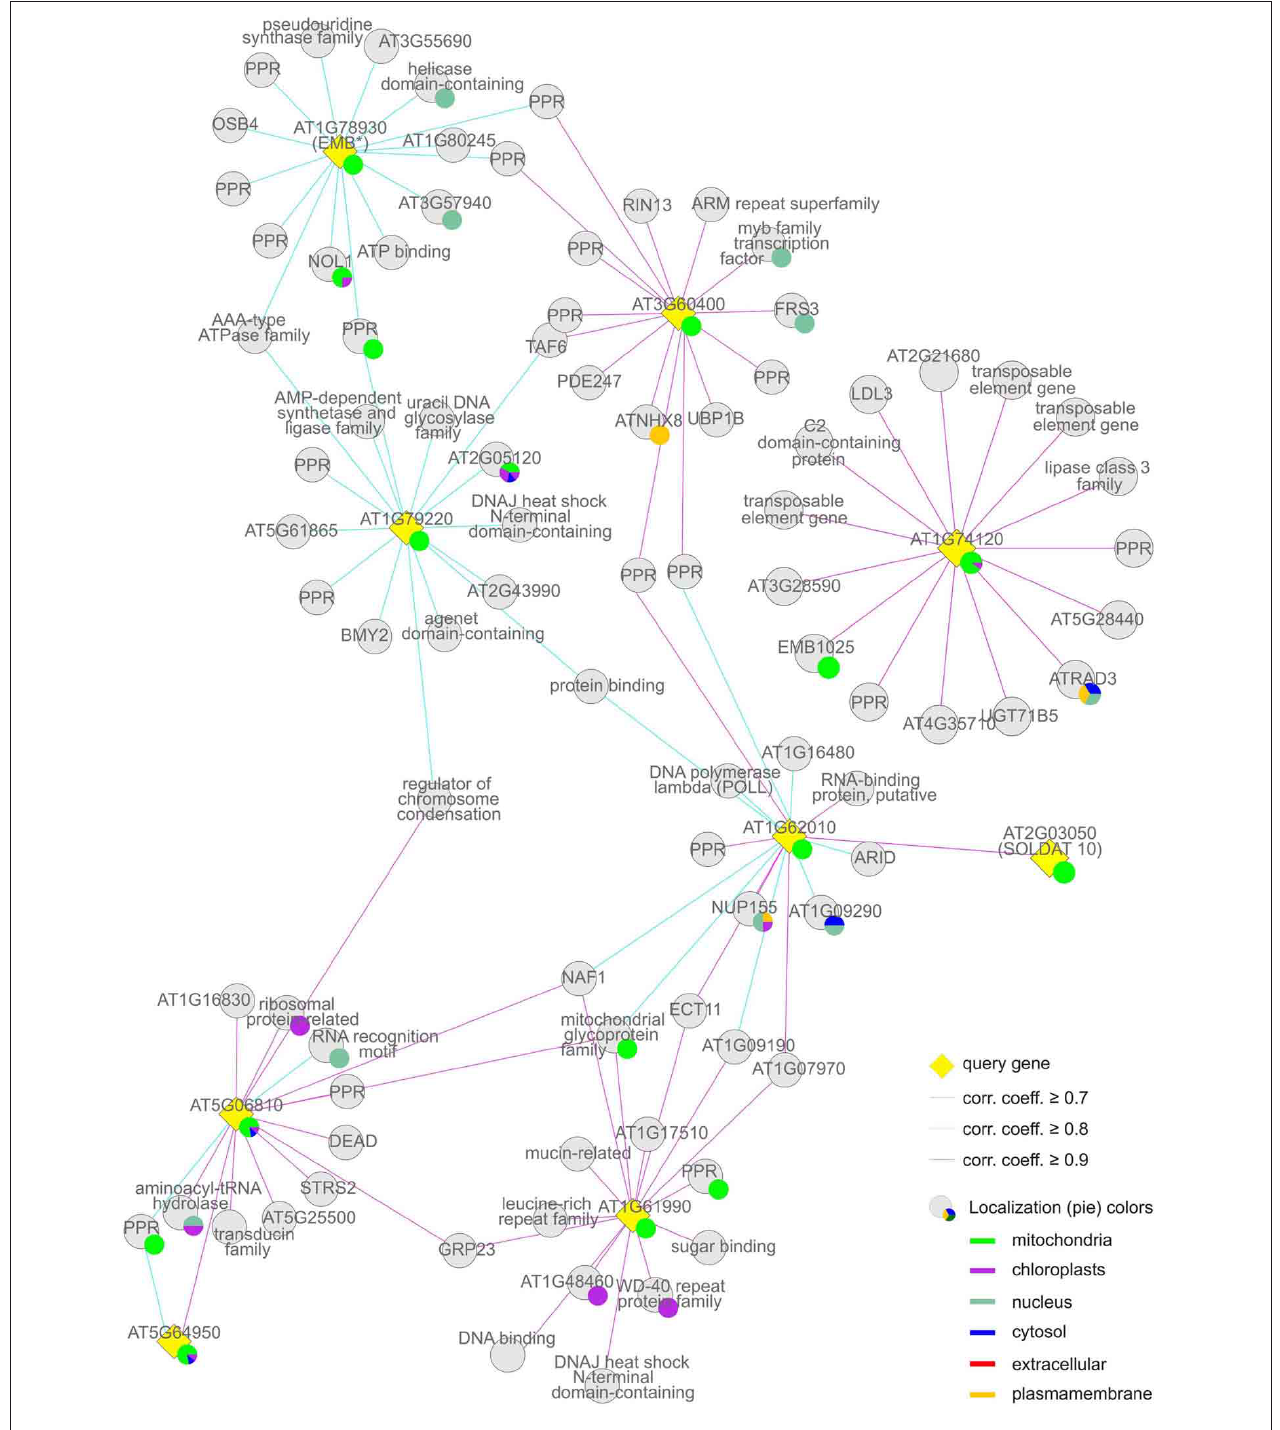
FIGURE 6 | Group (iii), the “mitochondrial” cluster. The coregulation network was generated as in Figure 4 .